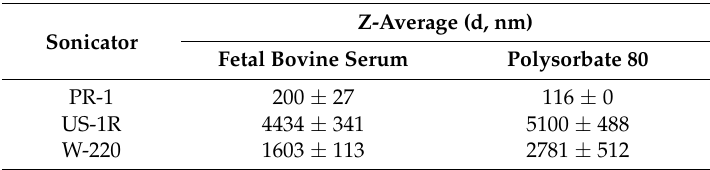
Figure 1. TEM images of Flotube 9110 (FT9110) dispersed by sonication for 1 h. The FT9110 were dispersed in 2% fetal bovine serum (FBS: a – c ), and in 0.1% polysorbate 80 (PS: d – f ) using PR-1 ( a , d ), US-1R ( b , e ) and W-220 ( c , f ) sonicators. Table 1. The size of Flotube 9110 agglomerates measured by Zetasizer.